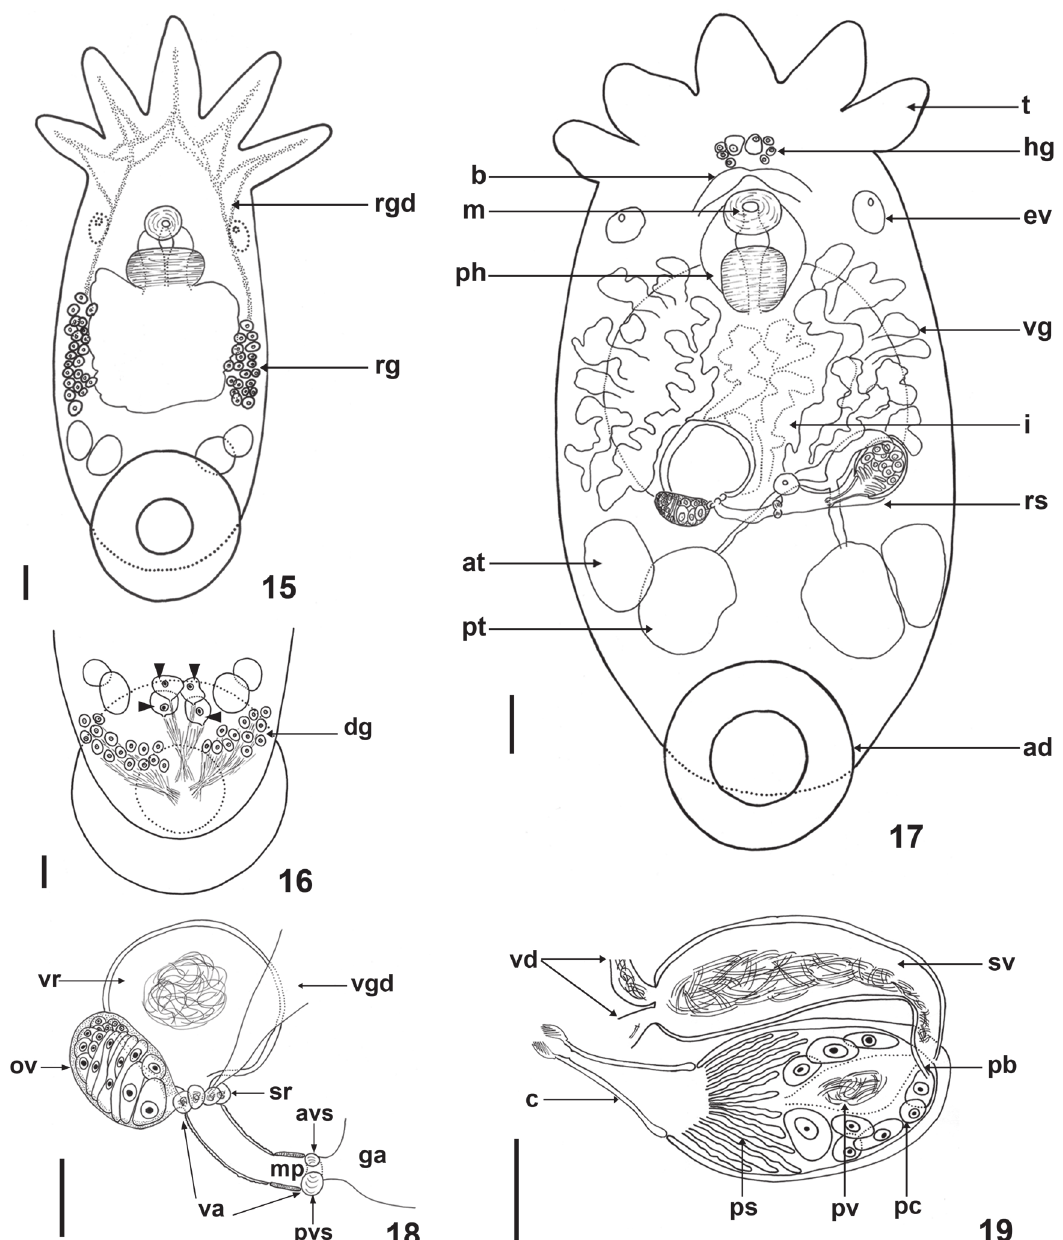
Figures 15-19. Temnocephala iheringi : (15) juvenile, ventral view, showing rhabditogenic glands (rg) extending along sides of intestinal sac, and its ducts (rgd) entering tentacles, bar = 100 µm; (16) dorsal view showing posterolateral disk glands (dg) and the two pairs of large disk glands (paranephrocytes?) (black head arrows), bar = 50 µm; (17) incomplete diagram of adult specimen fixed with cold AFA and slight cover slip pressure showing tentacles (t), Haswell glands (hg), brain transverse band (b), mouth (m), pharynx (ph) excretory vesicles (ev), vitellarium (v), intestinal sac (i), reproductive system (rs), anterior testes (at), posterior testes (pt), adhesive disk (ad), bar = 250 µm; (18) female reproductive complex, showing vesicula resorbens (vr), ovary (ov), seminal receptacles (sr), vagina (va), distal vagina with muscular portion (mp), anterior (avs) and posterior (pvs) portions of the vaginal sphincter, genital atrium (ga), bar = 100 µm; (19) male reproductive complex: vasa deferentia (vd), seminal vesicle (sv), prostatic bulb (pb), prostatic cells (pc), prostatic vesicle (pv), prostatic secretion (ps), cirrus (c), bar = 100 ZOOLOGIA 27 (2): 245–257, April, 2010